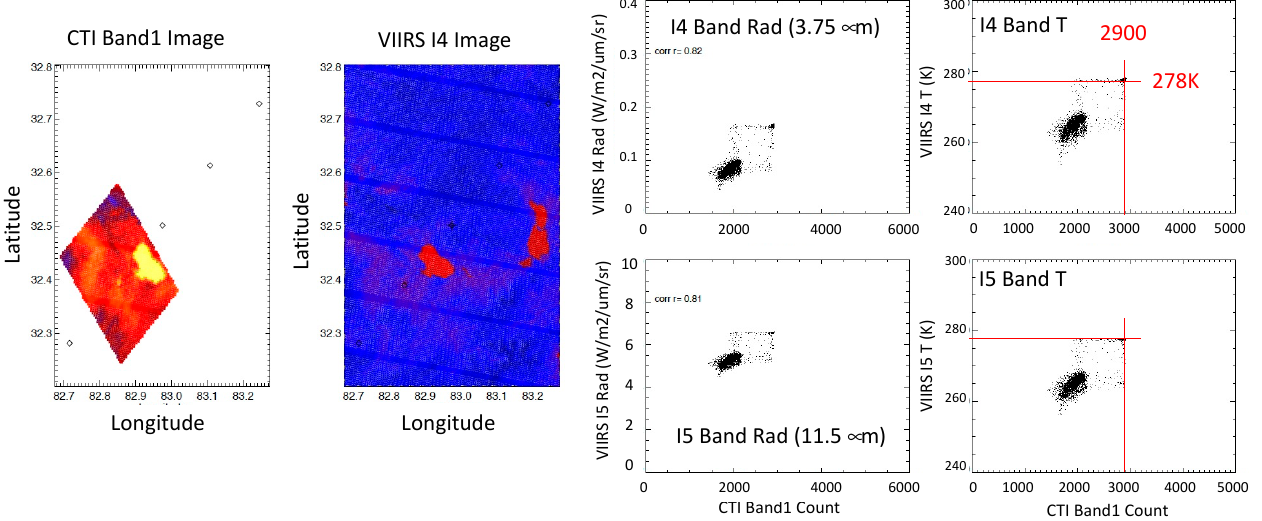
Figure A6. An example of nighttime CTI images mapped onto the lat–lon grid to collocate with the VIIRS radiance and temperature measurements acquired within an hour of CTI observations. The CTI flight track is indicated by the symbols in the leftmost image.